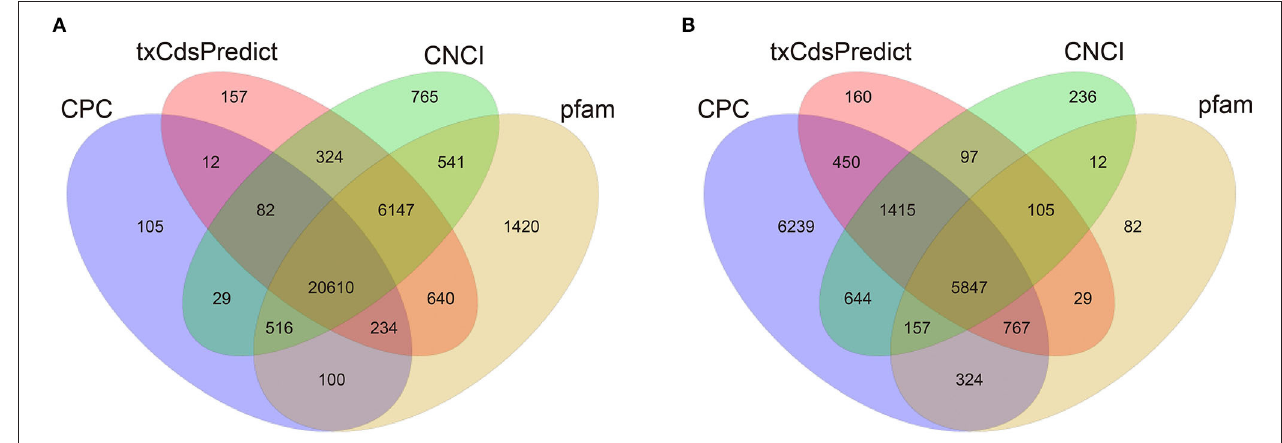
FIGURE 2 | Predicted lncRNAs and mRNAs of the PSG in Bombyx mori as filtered with CPC, txCdsPredict, and CNCI and compared with the Pfam database. Venn diagram of the lncRNAs (A) . Venn diagram of the mRNAs (B) .